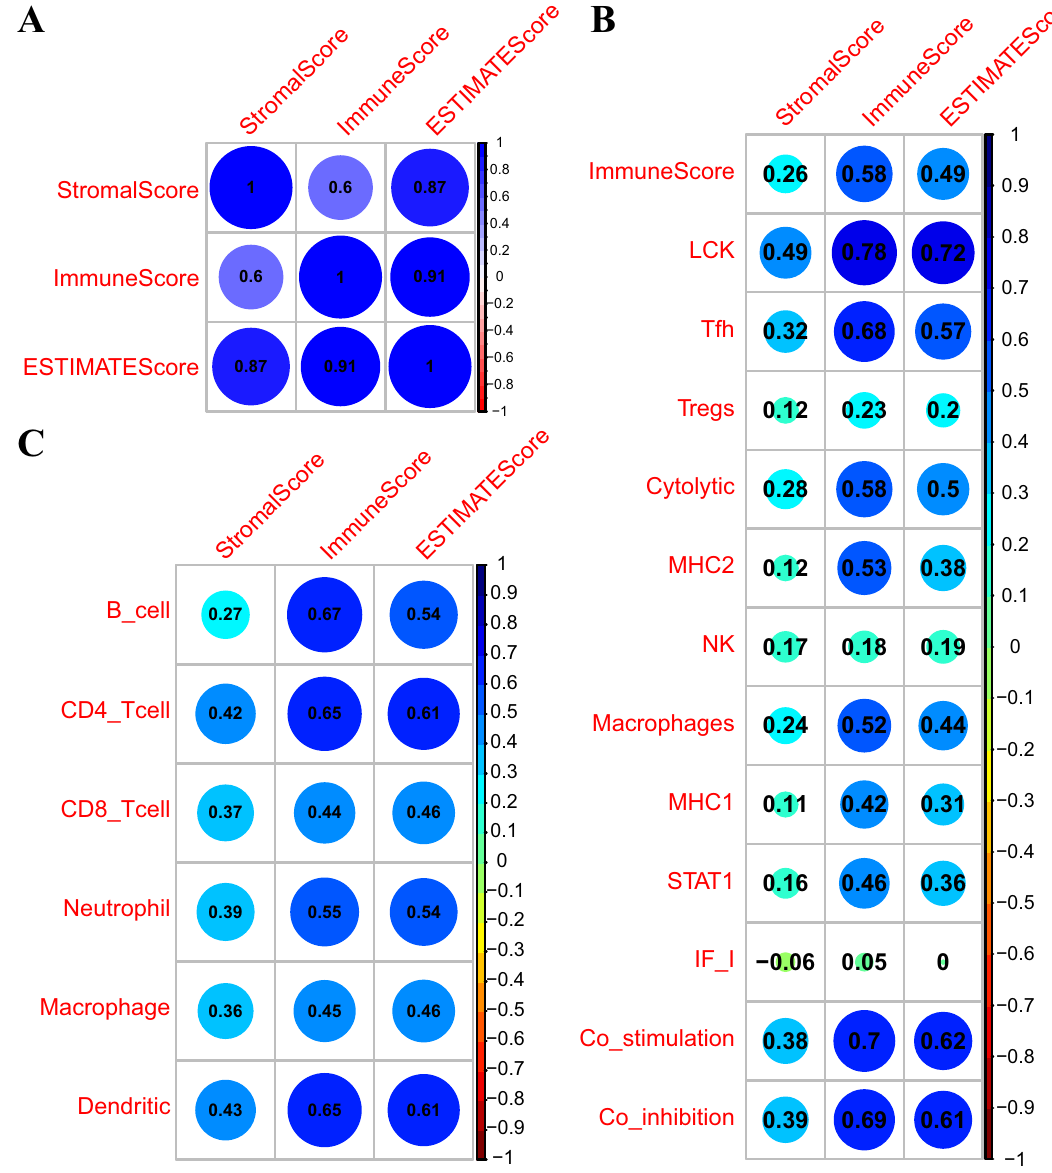
Figure 1. Correlations between ESTIMATE immune score and other immune scores for EC patients. ( A ) Correlations among the 3 ESTIMATE immune scores. ( B ) Correlations between 3 ESTIMATE immune scores and 13 metagenes scores for EC patients. ( C ) Correlations between 3 ESTIMATE immune scores and 6 immunocyte infiltration scores for EC patients. Coefficients of Spearman correlation were displayed color- coded, so as to demonstrate the negative (red) or positive (blue)